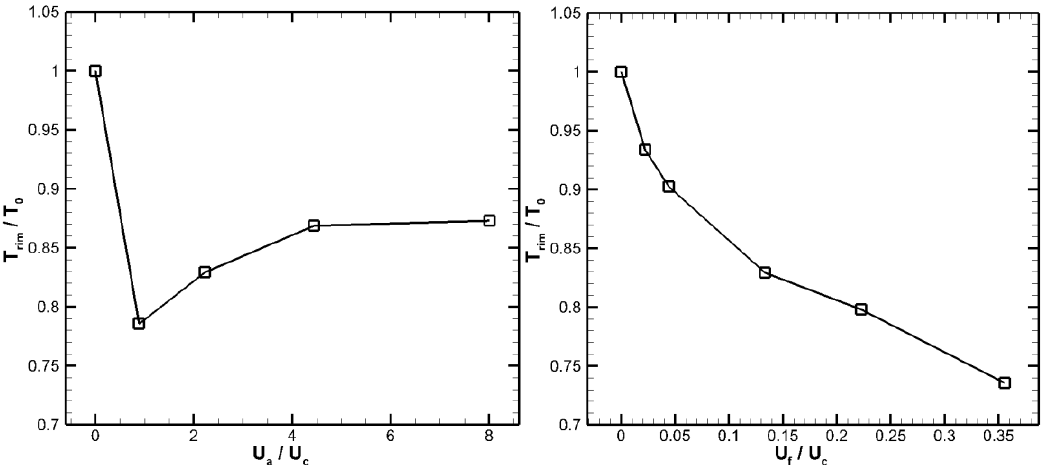
Figure 12. Effects of central air ( left ) and fuel ( right ) jet on the temperature of bluff-body surface